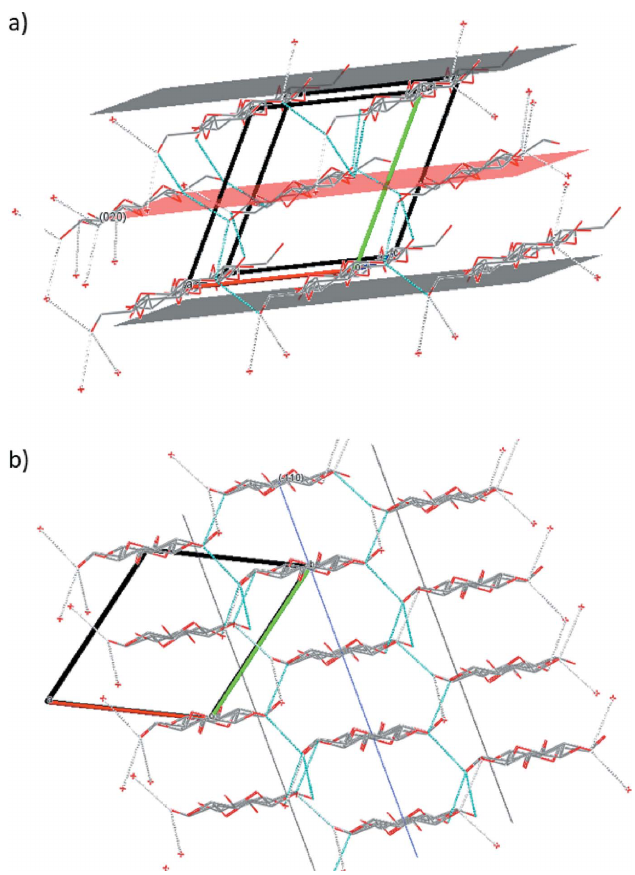
Figure 4 View of the structure of cellulose and the crystallographic planes: ( a ) for (020) and ( b ) for ( (cid:2) 1110). Structural data from French (2014).